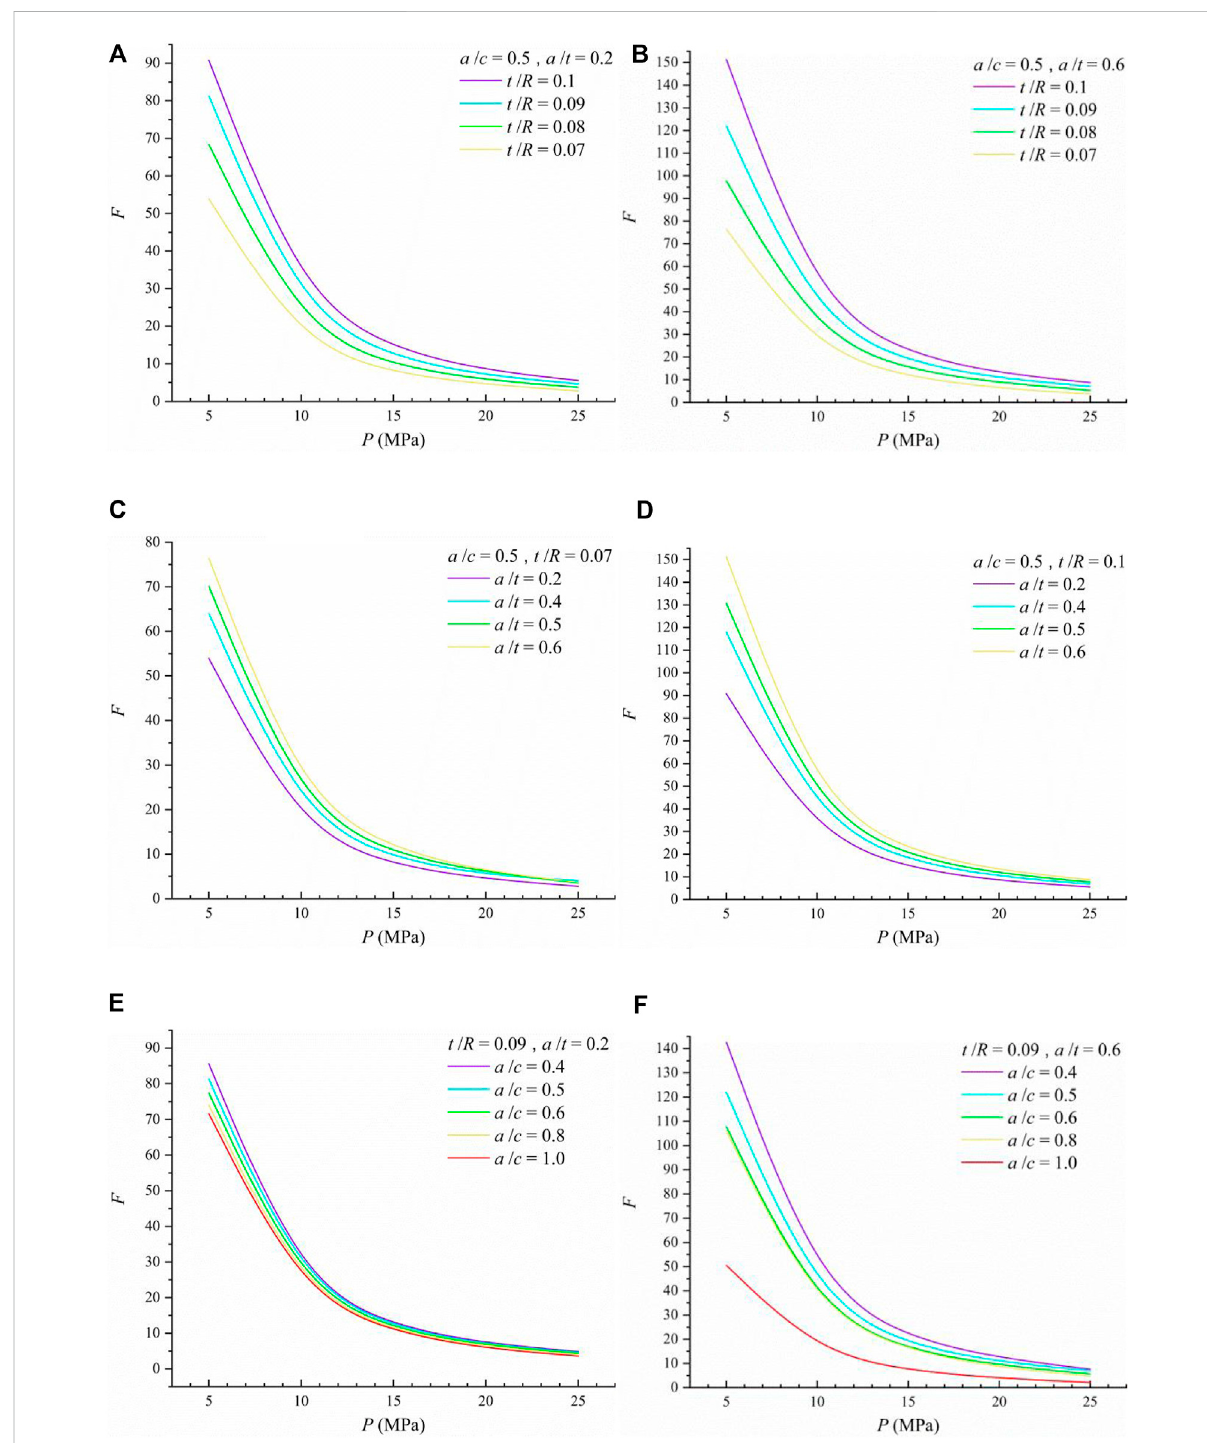
FIGURE 6 F-P curvesfromFEA. (A) F-P curveatdifferent t/R (semi-elliptical, a/c =0.5;shallow, a/t =0.2); (B) F-P curveatdifferent t/R (semi-elliptical, a/c = 0.5;deep, a/t =0.2); (C) F-P curveatdifferent a/t (semi-elliptical, a/c =0.5;thin-walled, t/R =0.07); (D) F-P curveatdifferent a/t (semi-elliptical, a/c = 0.5;thick-walled, t/R =0.1); (E) F-P curveatdifferent a/c (relativelythick-walled, t/R =0.09;shallow, a/t =0.2); (F) F-P curveatdifferent a/c (relatively thick-walled, t/R = 0.09 ; deep, a/t =